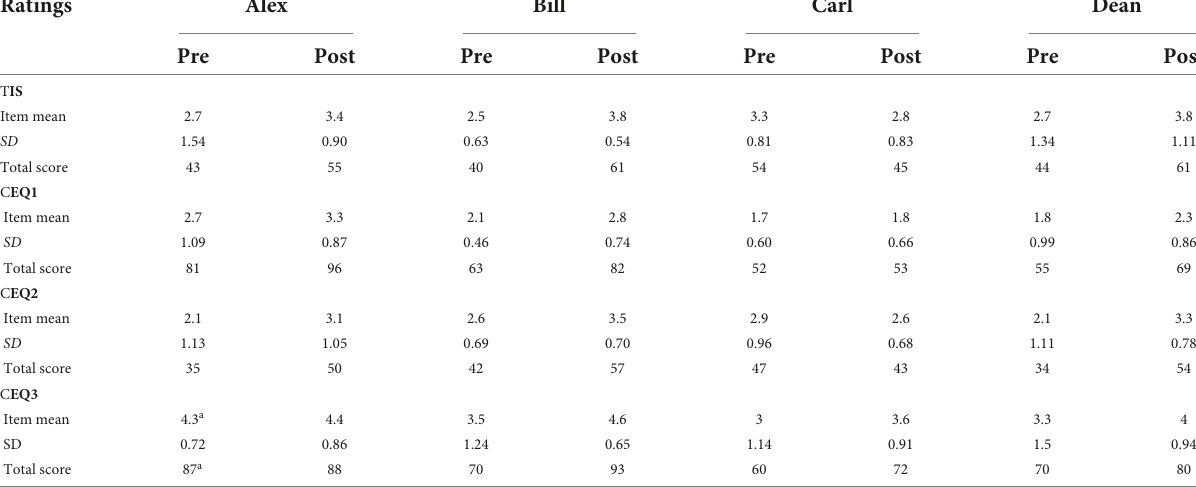
TABLE 6 Teachers’ ratings of social skills, engagement, and involvement in interactions with other children and preschool staff at pre and post PT/ST-intervention for children with SEND (Alex, Dean) and SEN (Bill, Carl) observed with the teacher impression scale (TIS) and three children engagement questionnaires